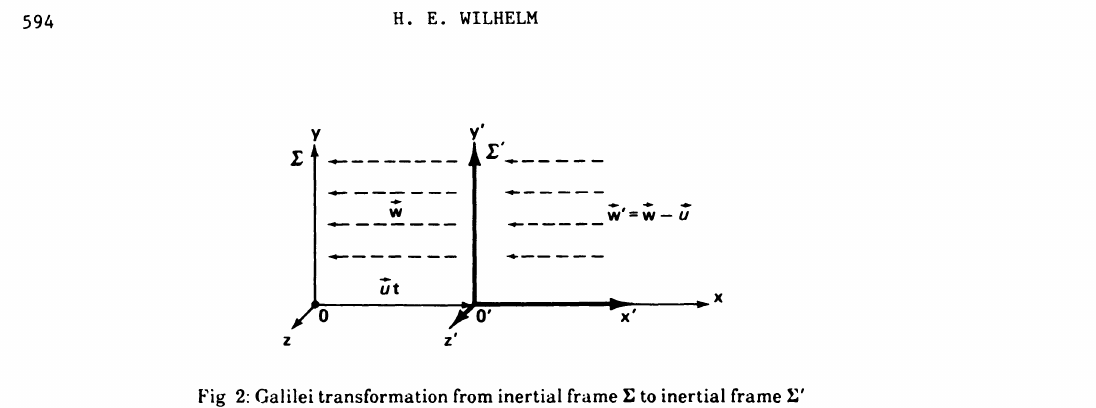
Fig 2: Galilei transformation from inertial frame :E to inertial frame where :E’ moves relative to :E with velocity u(0 0’ for t’